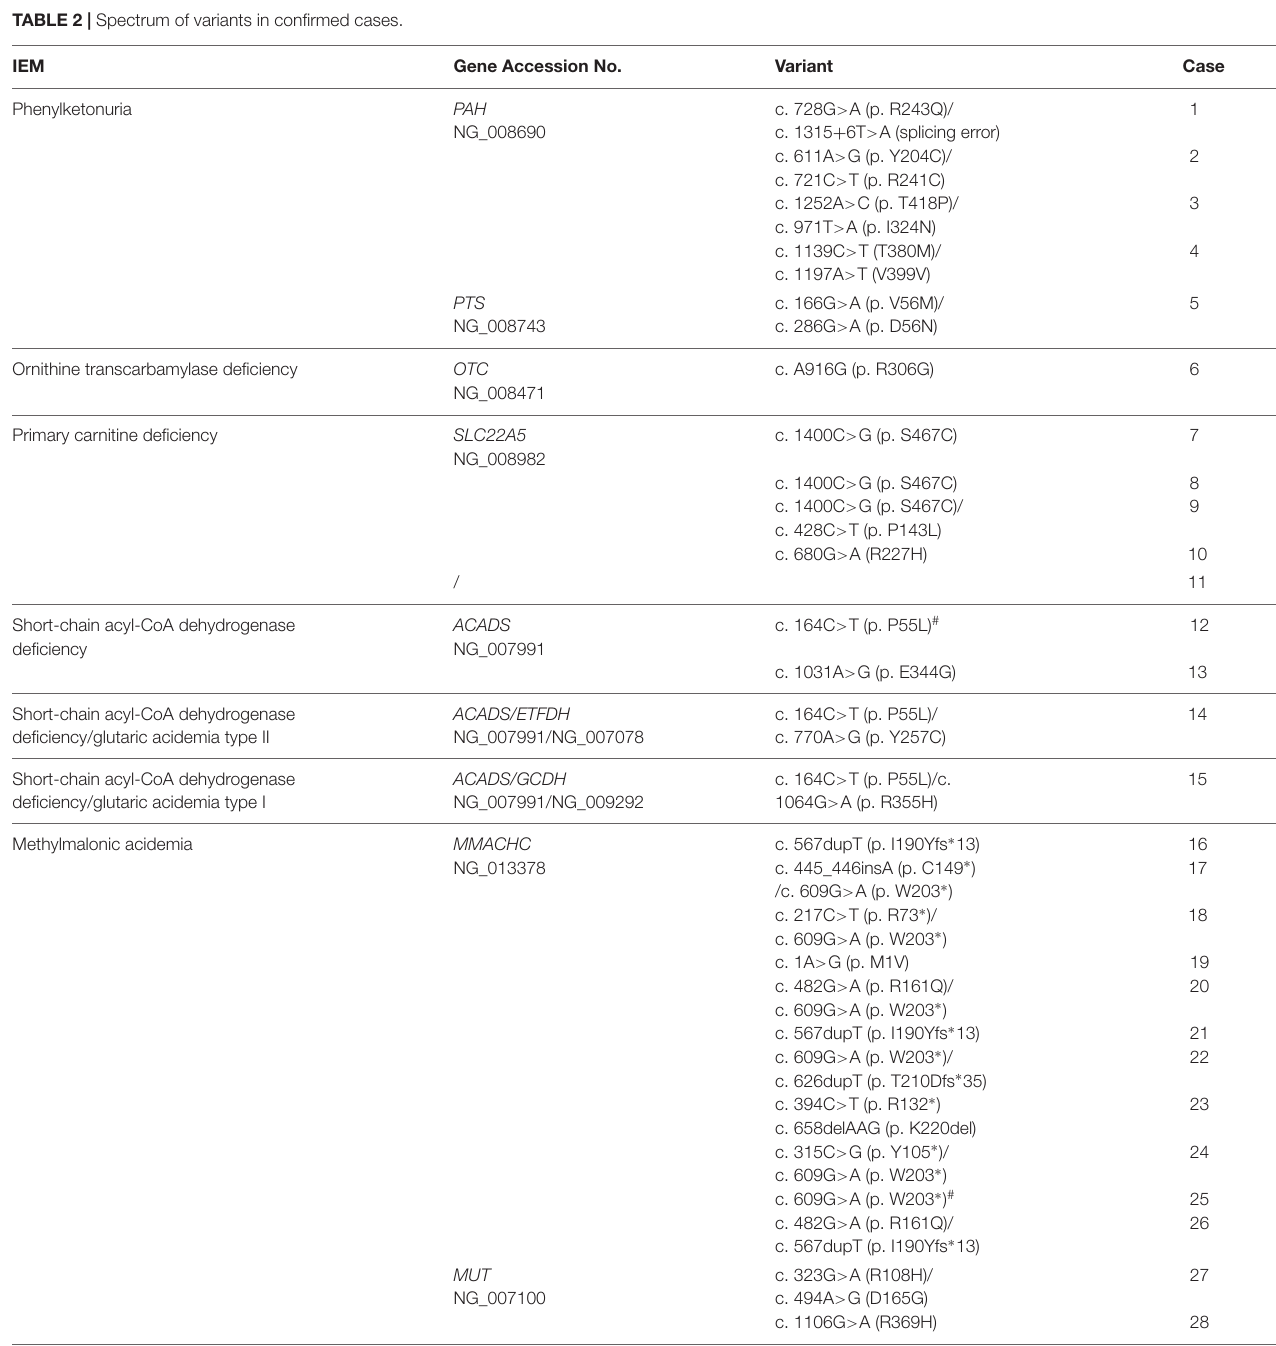
TABLE 2 | Spectrum of variants in confirmed